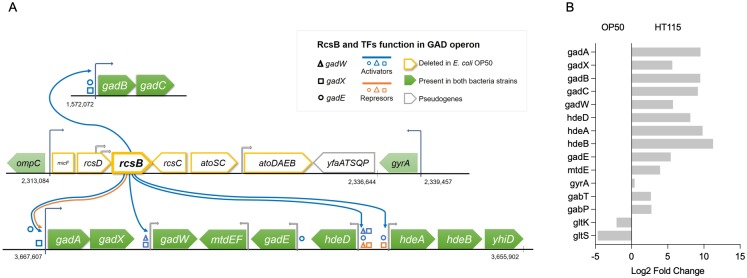
Enzymes of the GAD enzyme operon are uniquely and highly expressed in E. coli HT115.(A) Scheme of regulation of the gad operon. (B) Log2 Fold Change of genes coding for enzymes of GABA metabolism. The underlying numerical data and statistical analysis for each figure panel can be found in S1 Dataset and S2 File, respectively. GABA, γ-aminobutyric acid; GAD, glutamate decarboxylase; gad, glutamate decarboxylase enzyme gene; rcs, regulator of capsular system.